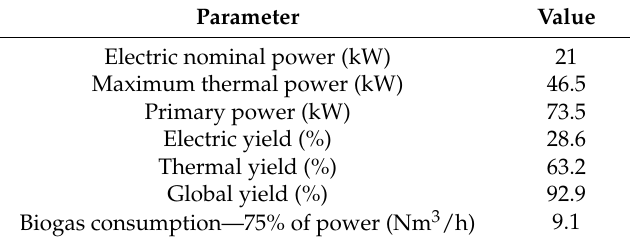
Table 2. Basic technical specifications.